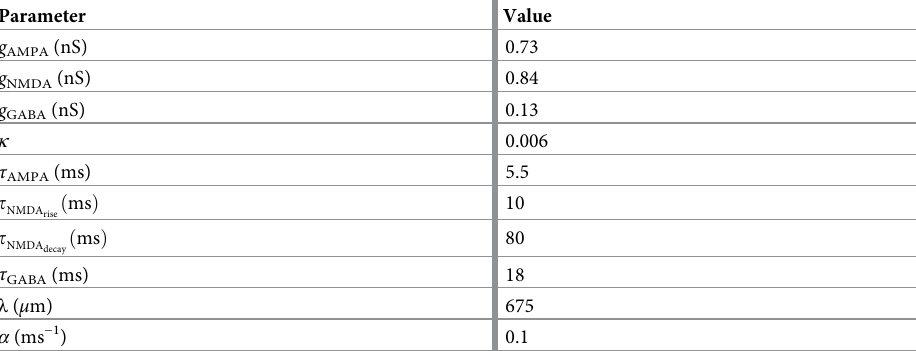
Table 2. Synaptic